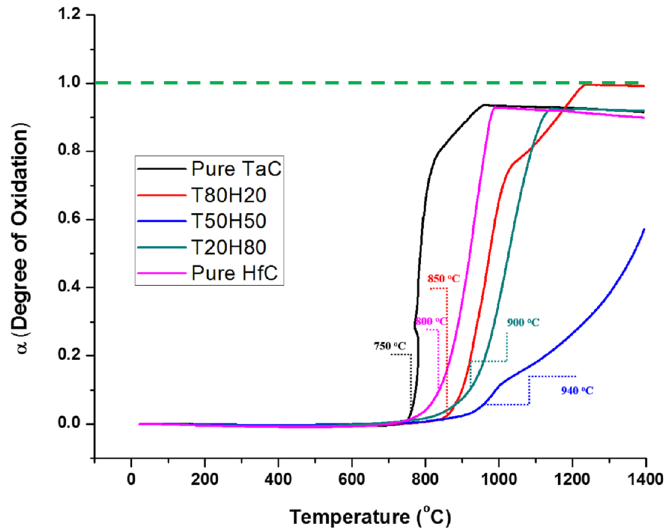
Figure 3. TG curve of TaC, HfC, and TaC ‐ HfC solid solutions.